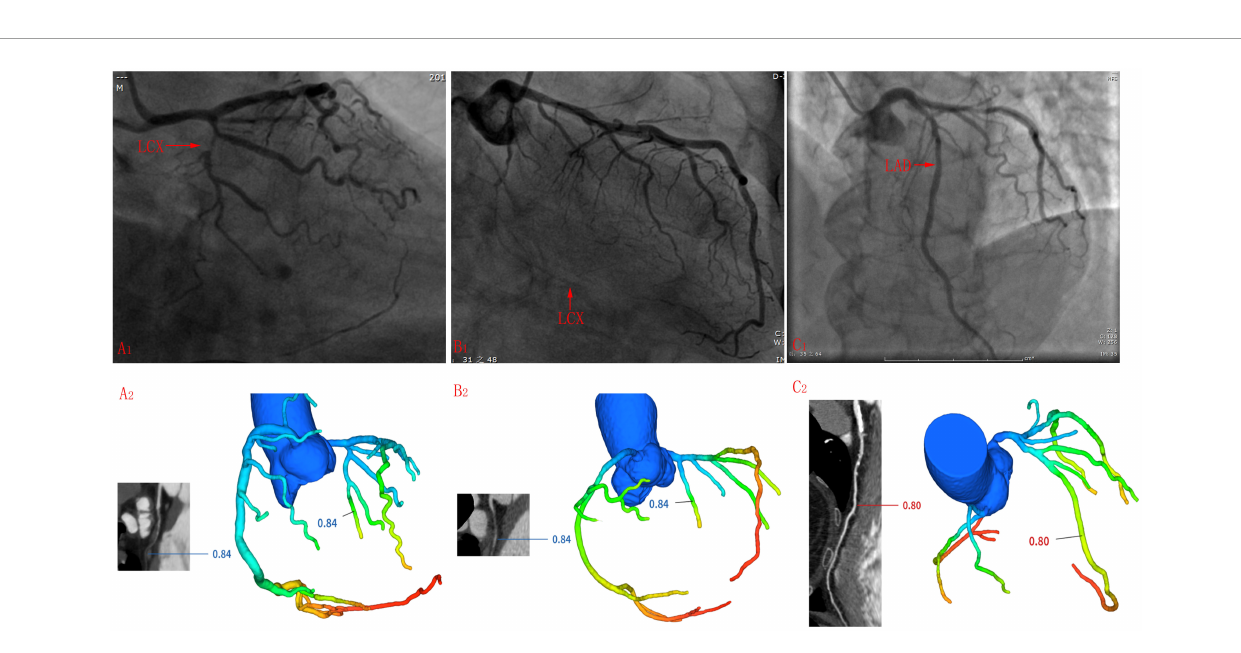
FIGURE4 Cases whose ICA results were inconsistent with FFRCT. (A1,A2) LCX was too small to reconstruct the distal end during three-dimensional reconstruction before calculating the FFRCT value. (B1,B2) The middle segment of the LCX was occluded, so it is impossible to reconstruct the middle and far sections of the LCX when undergoing the three-dimensional reconstruction before calculating the FFRCT value, and the FFRCT value of the near LCX segment was given. (C1,C2) Long segment calcification was seen in the mid-LAD